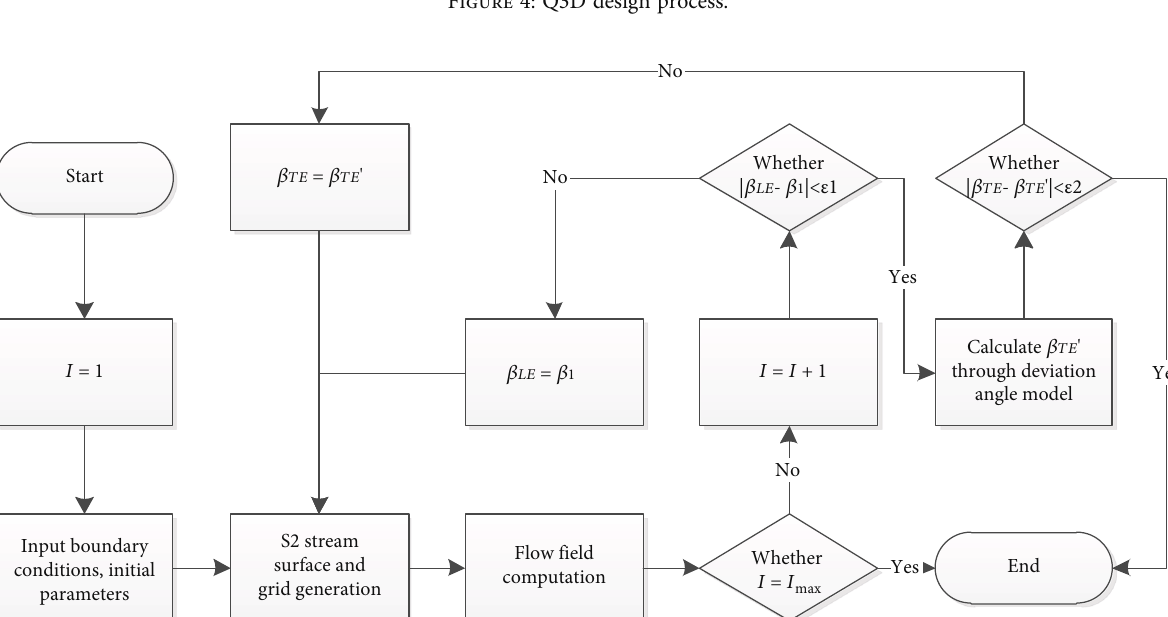
Figure 4: Q3D design process.